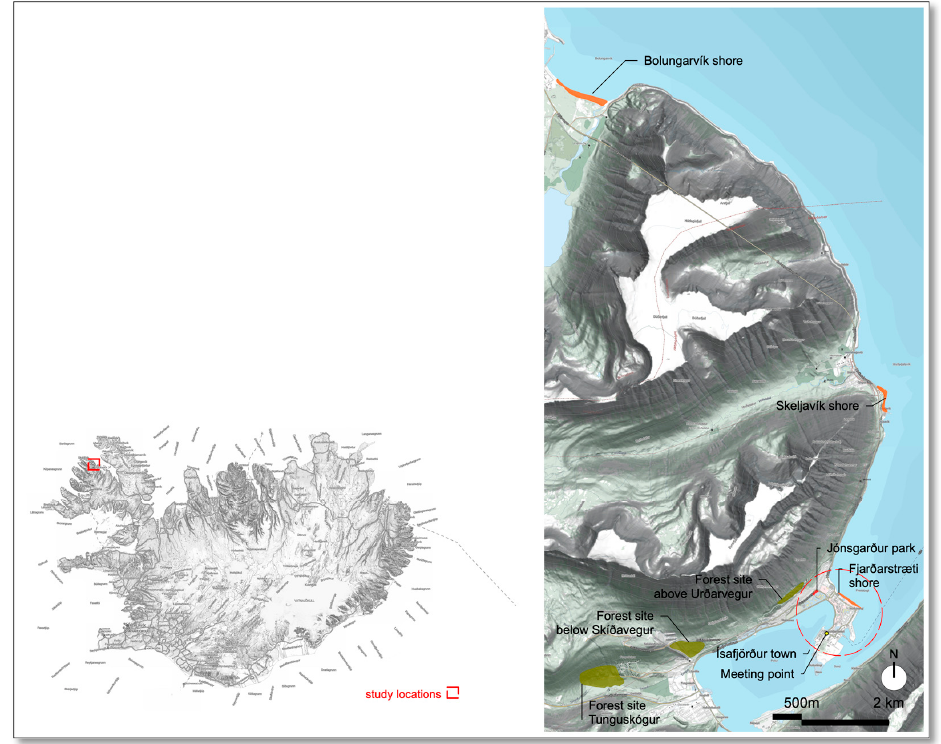
Figure 1. The map on the left shows where in Iceland the study took place. The map on the right shows the seven nature sites with seashores colored orange, forests green, and the park red.